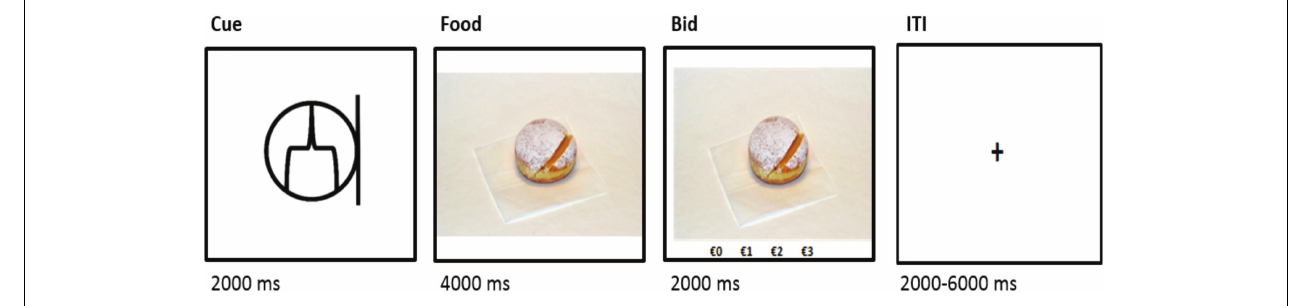
FIGURE 1 | Timing and structure of a trial from the functional magnetic resonance task. ITI, intertrial interval.